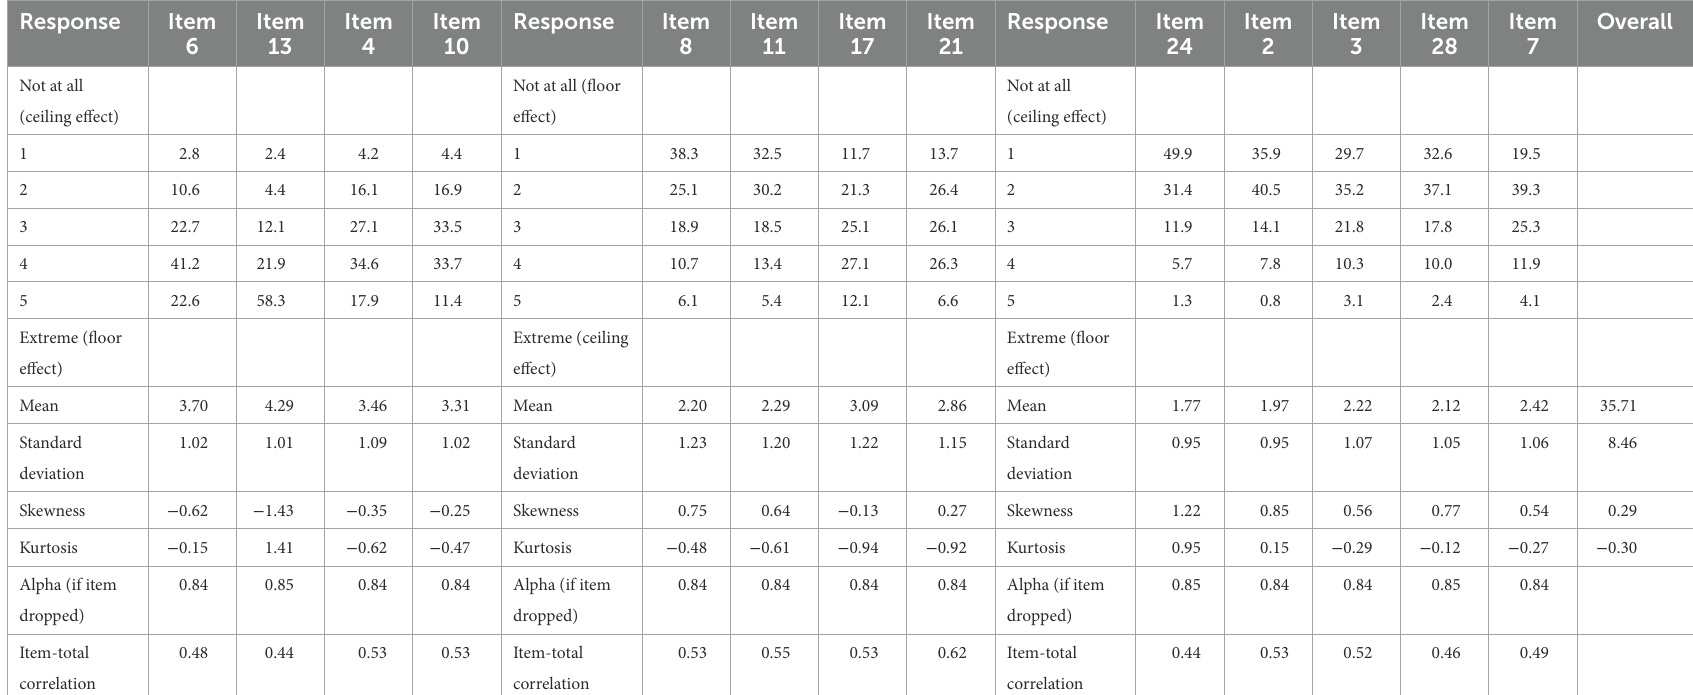
TABLE 5 The item statistics of FPQ-III short